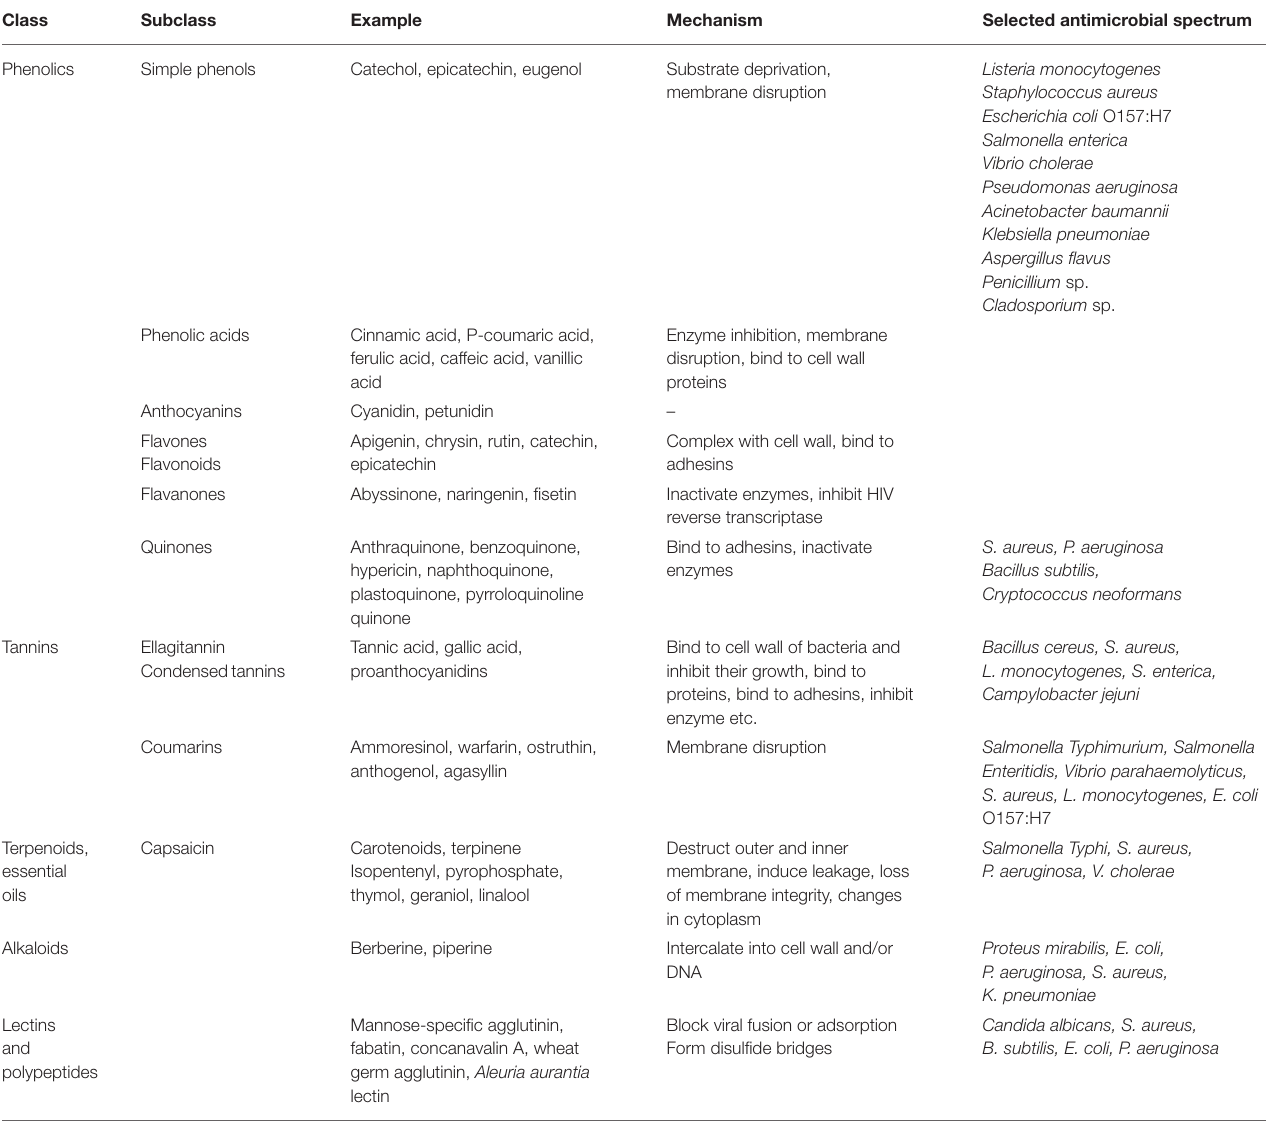
TABLE 1 | Major classes of antimicrobial compounds, proposed mechanisms of action, and antimicrobial spectrum of plants and plant